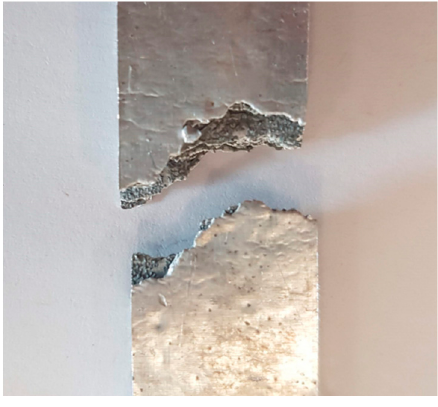
14 of 18 Figure 14. Fracture modes: ( a ) Al 1050; ( b ) CMFM specimen. 3.4. Results from Corrosion Test of Dog Bone Specimens Galvanic corrosion is a major concern with aluminium, and any corrosion in the bond–foil interface would have seriously undermined the strength of the dog bone specimens. This test was performed to assess the effect of corrosion on the tensile strength and elongation of the specimens